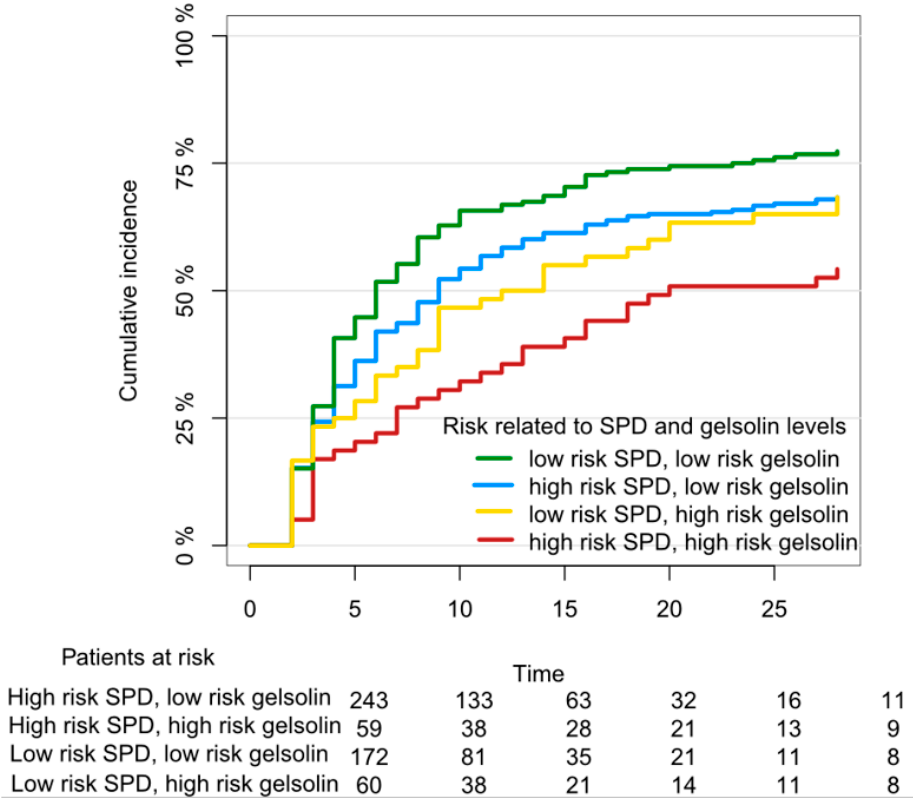
Figure 1. Chance for “successful weaning” from a ventilator within 28 days in critically ill patients according to blood levels of lung injury biomarkers Surfactant Protein D and Gelsolin, adapted from Holm et al. [4]. Gelsolin categories are quartiles and “high-risk gelsolin” is the lowest quartile, “low-risk gelsolin” was the three remaining quartiles. “High-risk SPD” was the upper 15%-percentile, “low-risk SPD” were all other SPD measurements, according to Jensen et al. [1].